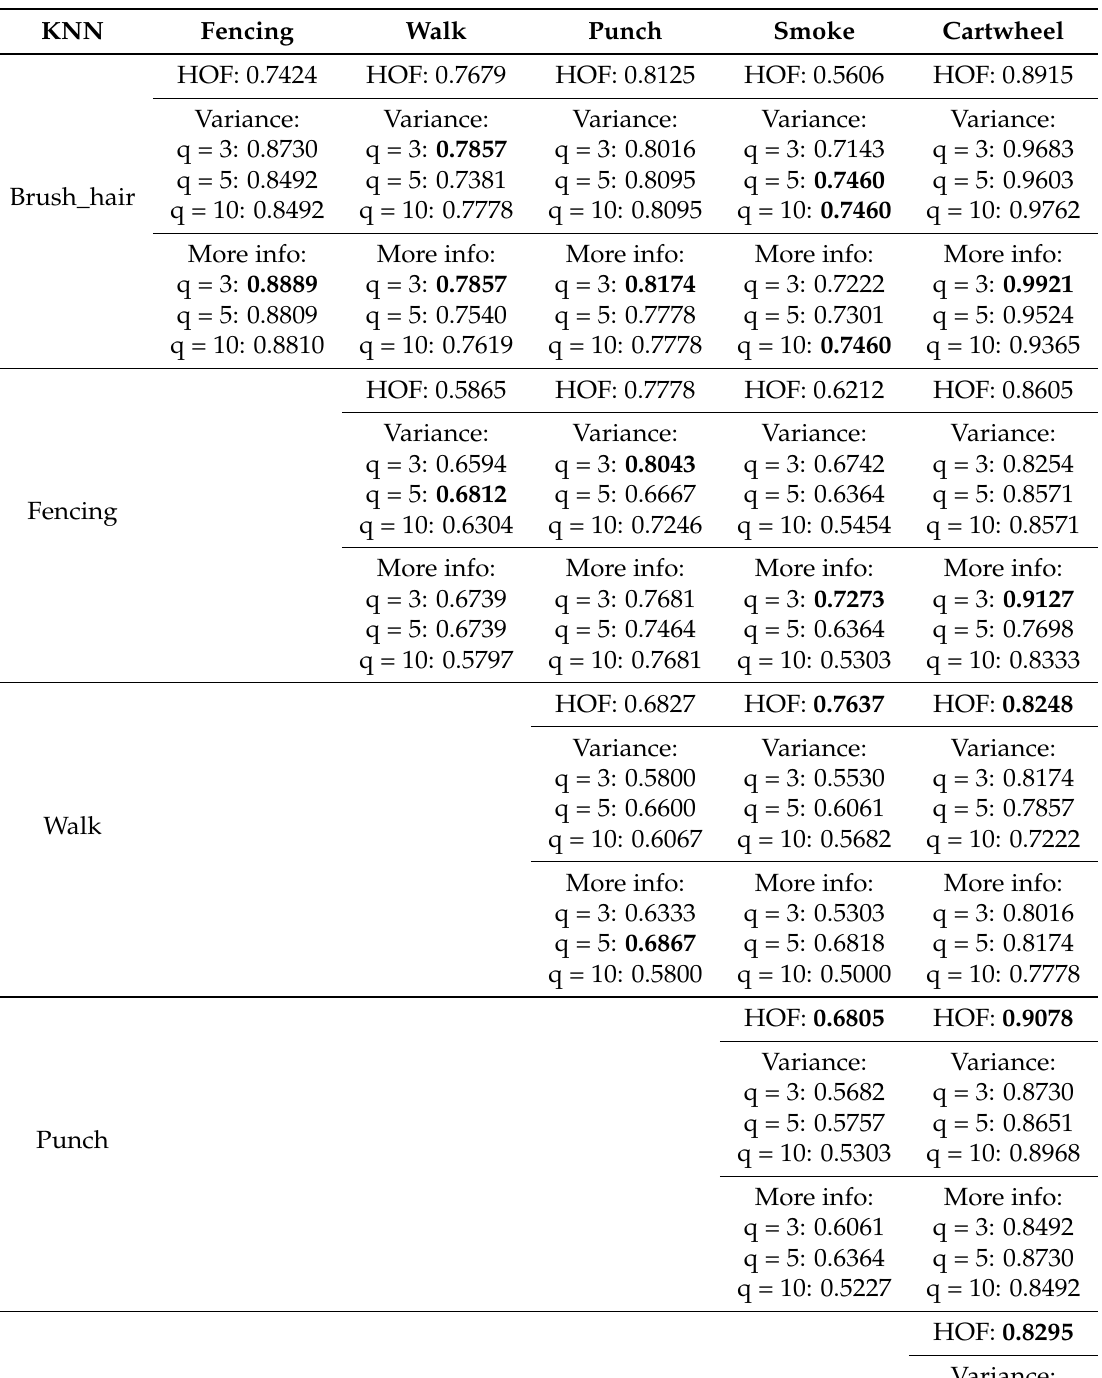
Table 2. K Nearest Neighbors (KNN) classifier results. Fencing Walk Punch Smoke